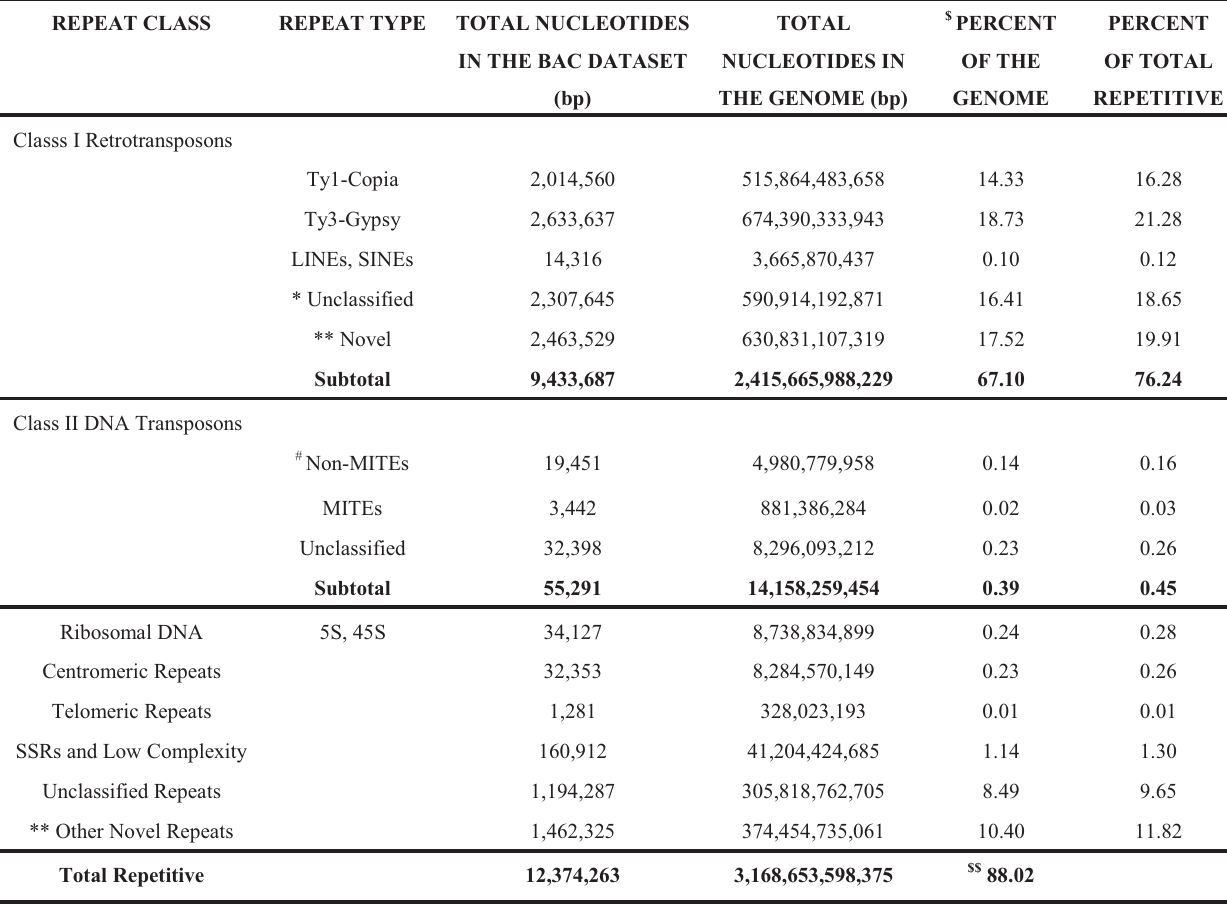
Table 1. Repeat composition of the sunflower genome as determined by RECON [46], RepeatScout [47] and RepeatMasker